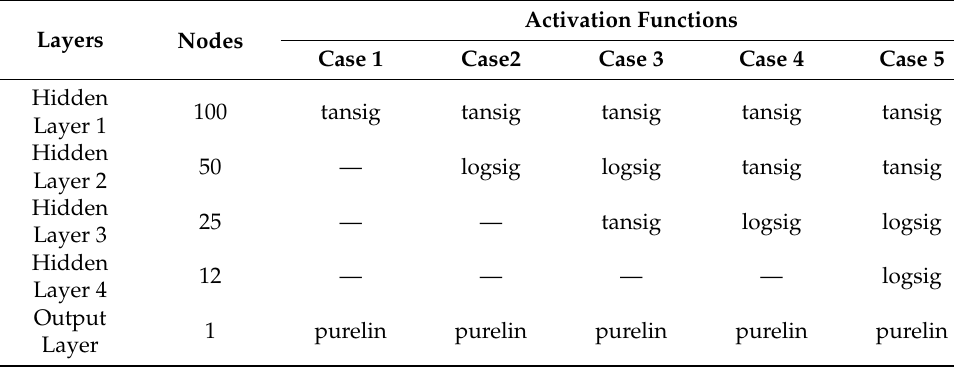
Table 3. Neural network configurations designed for each case. Layers